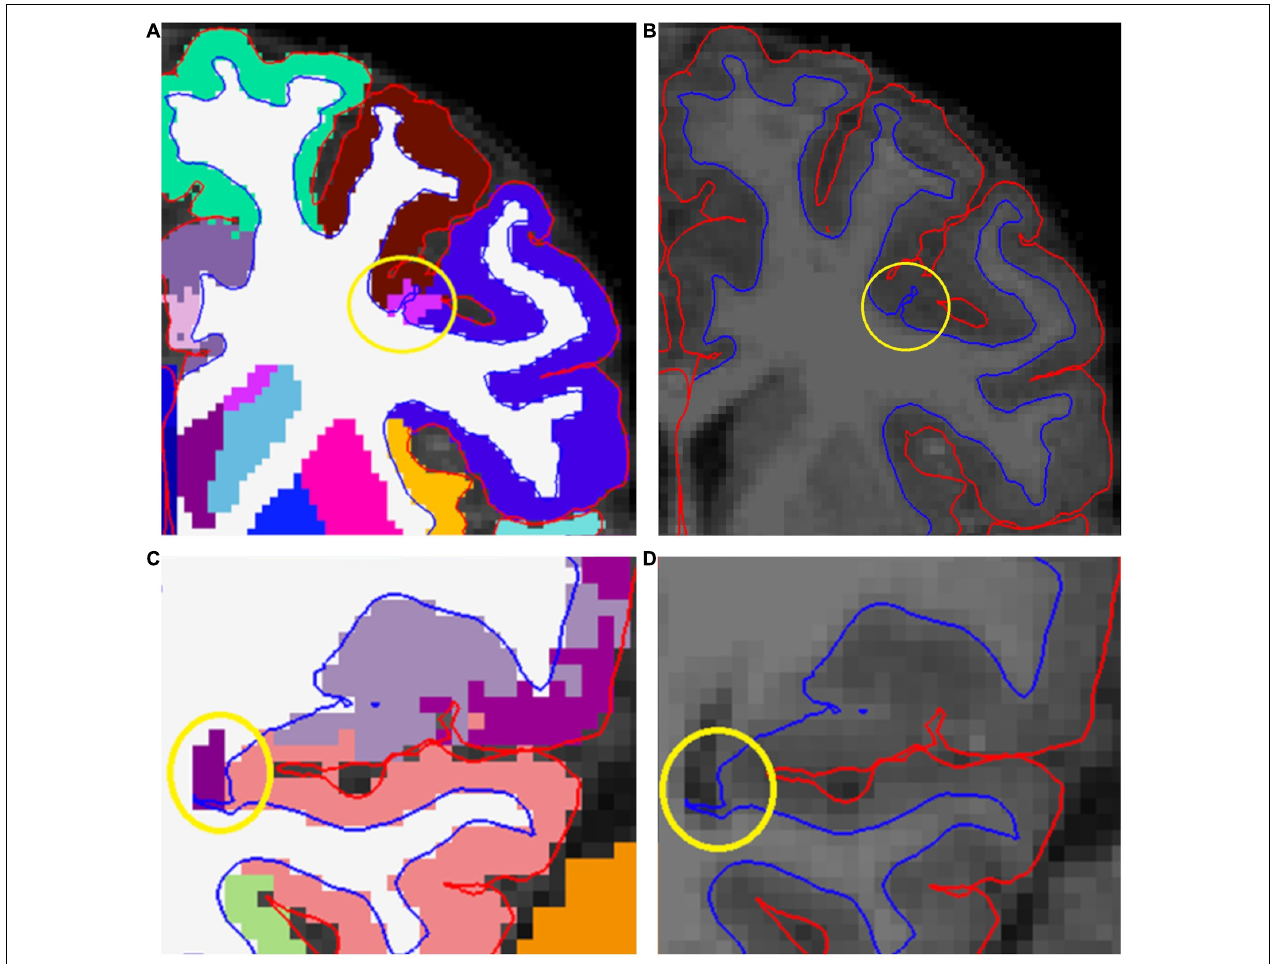
FIGURE 5 | (A,B) Show a white matter (WM) hypointensity that affects the border between white and gray matter (WM–GM border), denoted by a yellow circle. (C,D) Show how the posterior part of the lateral ventricle causes distortion to the WM–GM border (yellow circle). If the error was not successfully fixed, all regions adjoining the error were